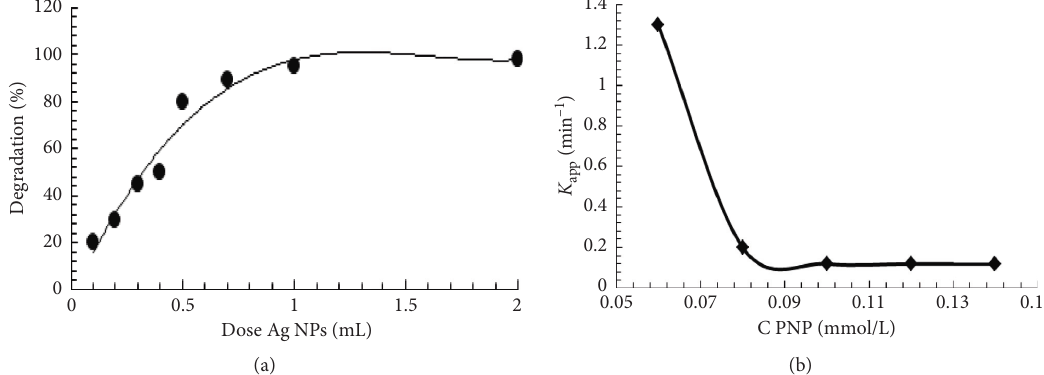
Figure 6: Catalytic reduction of 4-nitrophenol (4-NP) to 4-aminophenol (4-AP) with the Ag NPs as the nanocatalyst ( a ); ln ( A / A reaction time (b).